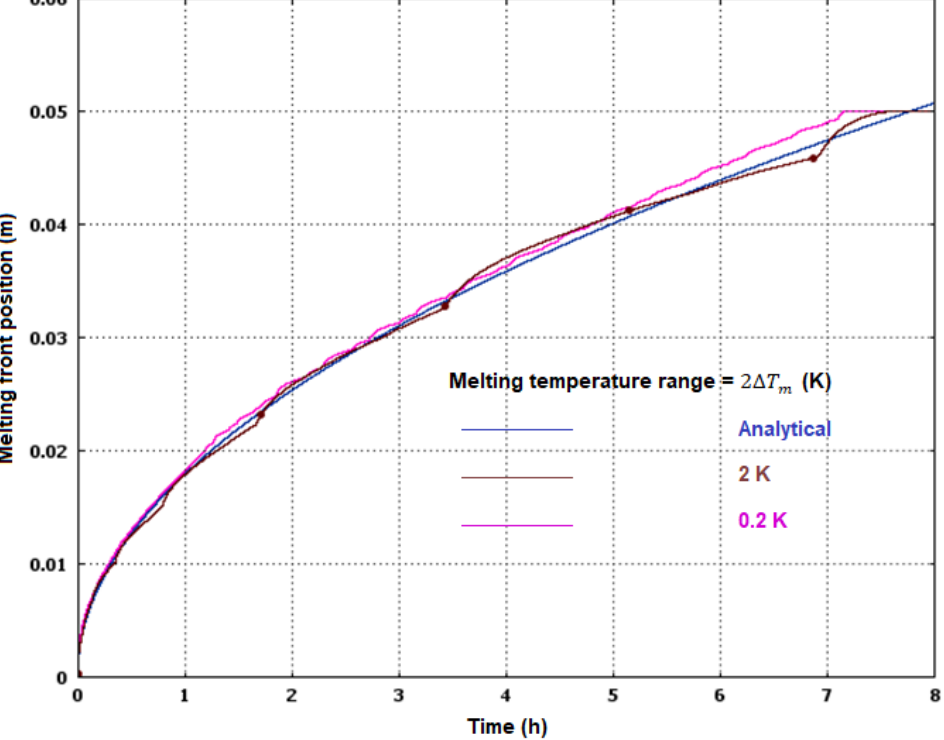
Figure 11. Effect of meshing qualities on the heat capacity. 5. Conclusions In the present paper, a simulation model for the PCM layer in the PCM Matrix Ab- sorber that is used for passive thermal management of PV modules has been developed and validated against an analytical solution for ice melting in a semi-finite slab. The model neglects intra PCM convection heat transfer and assumes that the solid-liquid phase change takes place over a mushy region rather than a sharp melting temperature. A sim- plified modeling approach and numerical procedures have been implemented in COM- SOL Multiphysics FEM software using the apparent heat capacity formulation and ho- mogenization based on volume averaging techniques. The simulation model has been de- veloped to determine the macroscopic transport and time history of the PCM temperature